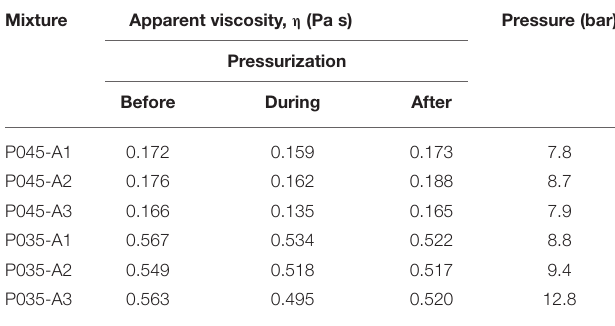
TABLE 3 | Summary of apparent viscosity changes due to pressurization.